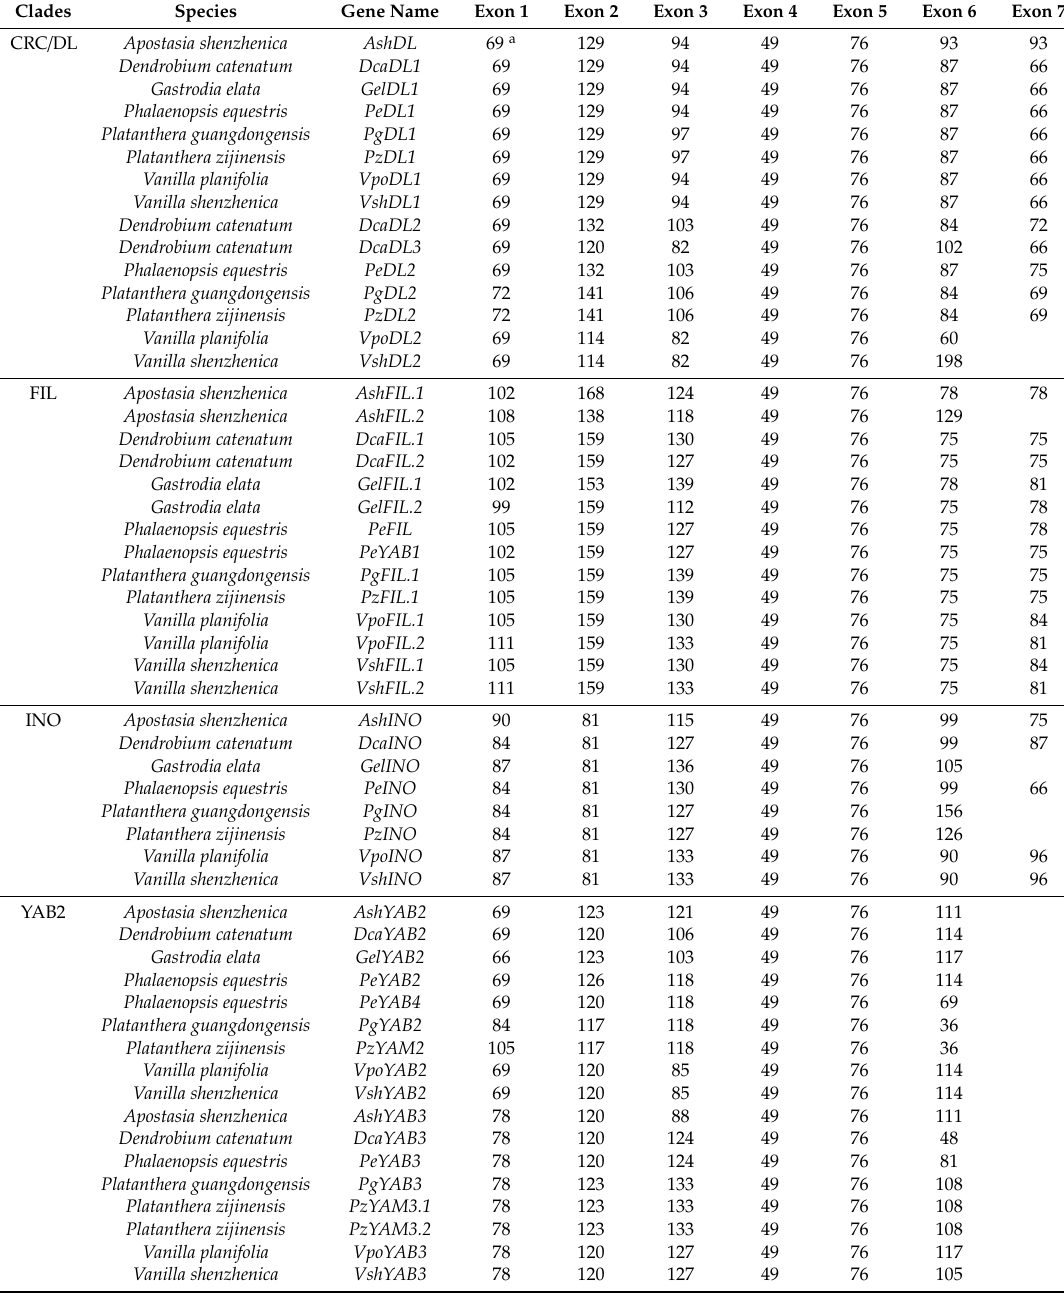
Table 1. The gene structures of the YABBY genes in the exon